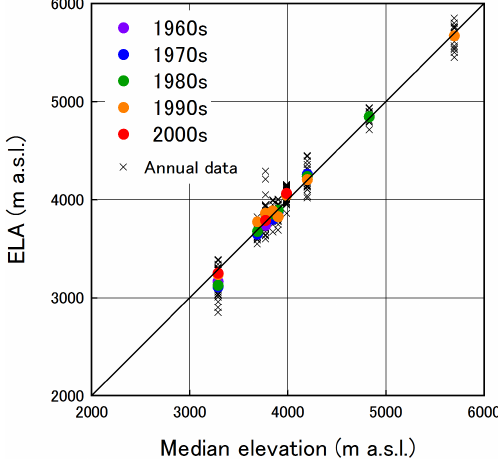
Figure 2. Relation between median elevation derived from the GGI and annual observed ELAs (cross marks) and decadal average of observed ELA (coloured circles) on nine glaciers in high-mountain